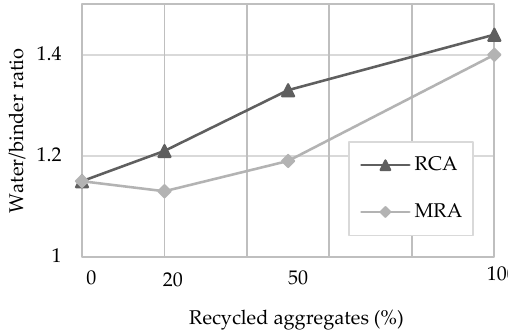
Figure 2. Water / binder of the produced mortars. Figure 2. Water/binder of the produced mortars.